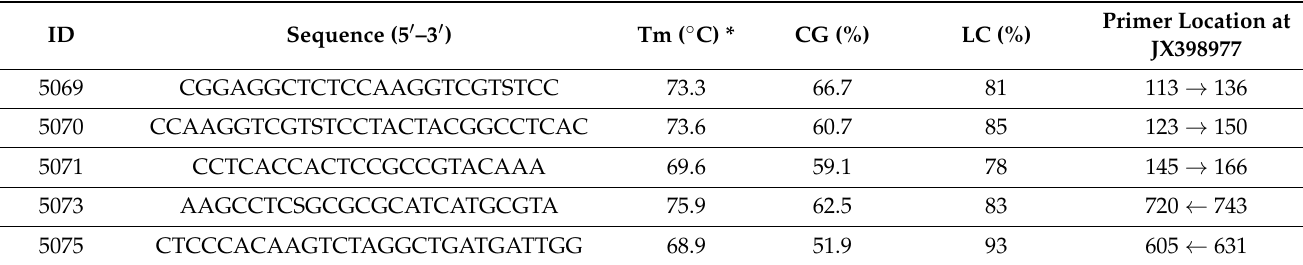
Table 5. Universal primers used in the analysis of polymorphisms of allelic variations of superoxide dismutase (SOD) gene families using multi-locus EPIC-PCR